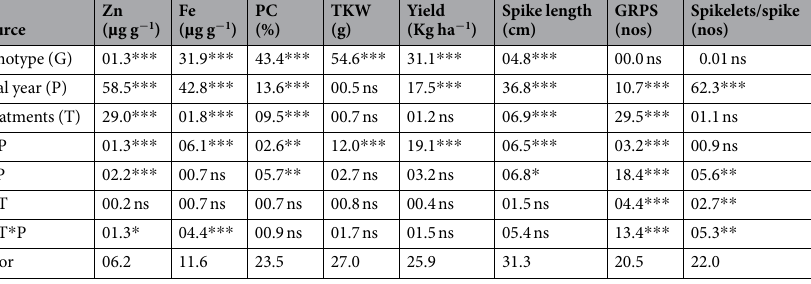
Table 1. Contributions $ due to genotype, trial # (year), foliar treatments on grain characteristics. $ % of total sum of squares from 3-way ANOVA, *** p < 0.001, ** p < 0.01, * p < 0.05 and ns denotes not significant. PC denotes protein content, TKW denotes thousand kernel weight, GRPS denotes grains per